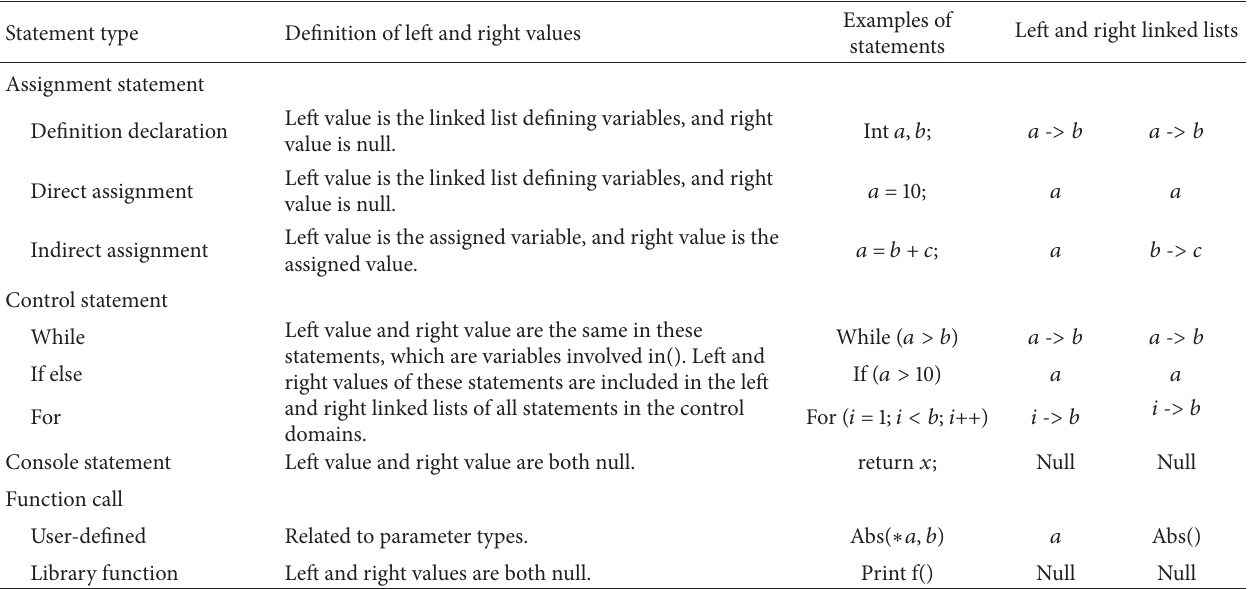
Table 1: Definitions of different statements data